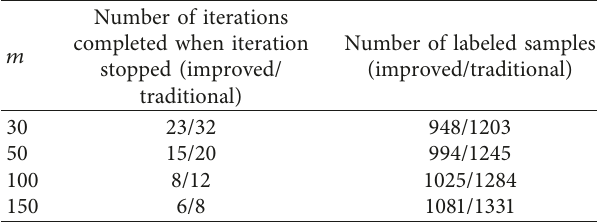
Table 5: Statistical results (when the iteration stop condition is not